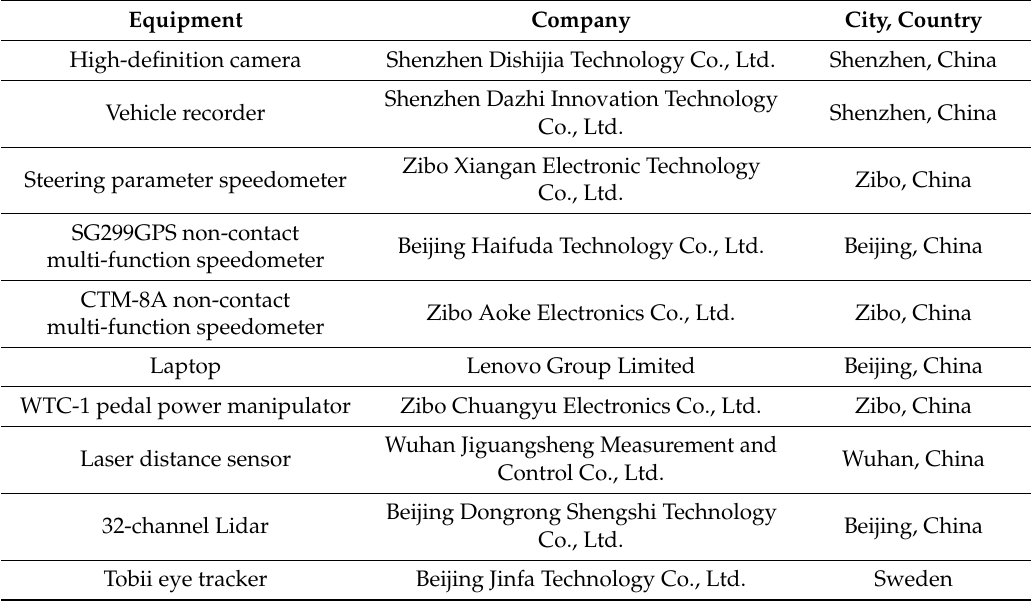
Table A1. Company information for the experimental